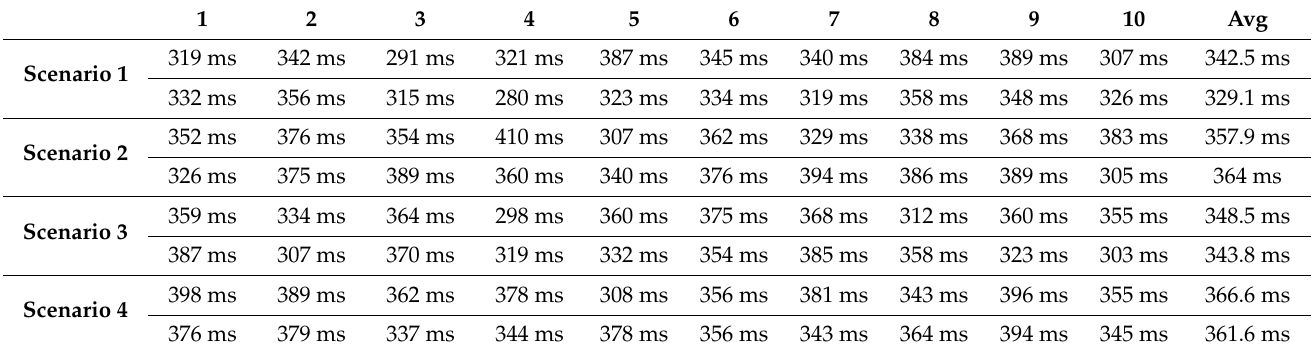
Table 4. Response time of control in driver assistance system.